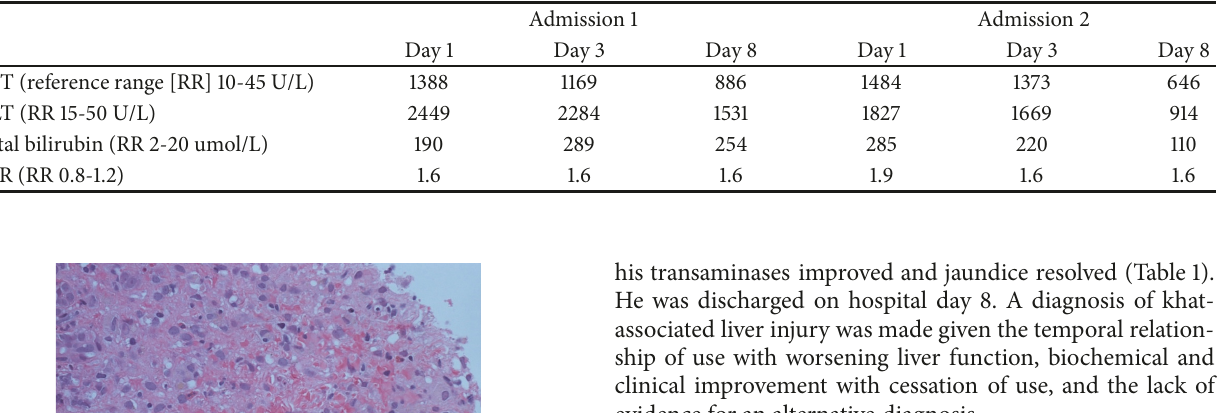
Table 1: Liver enzymes and liver function studies during the patient’s 2 hospital admissions.